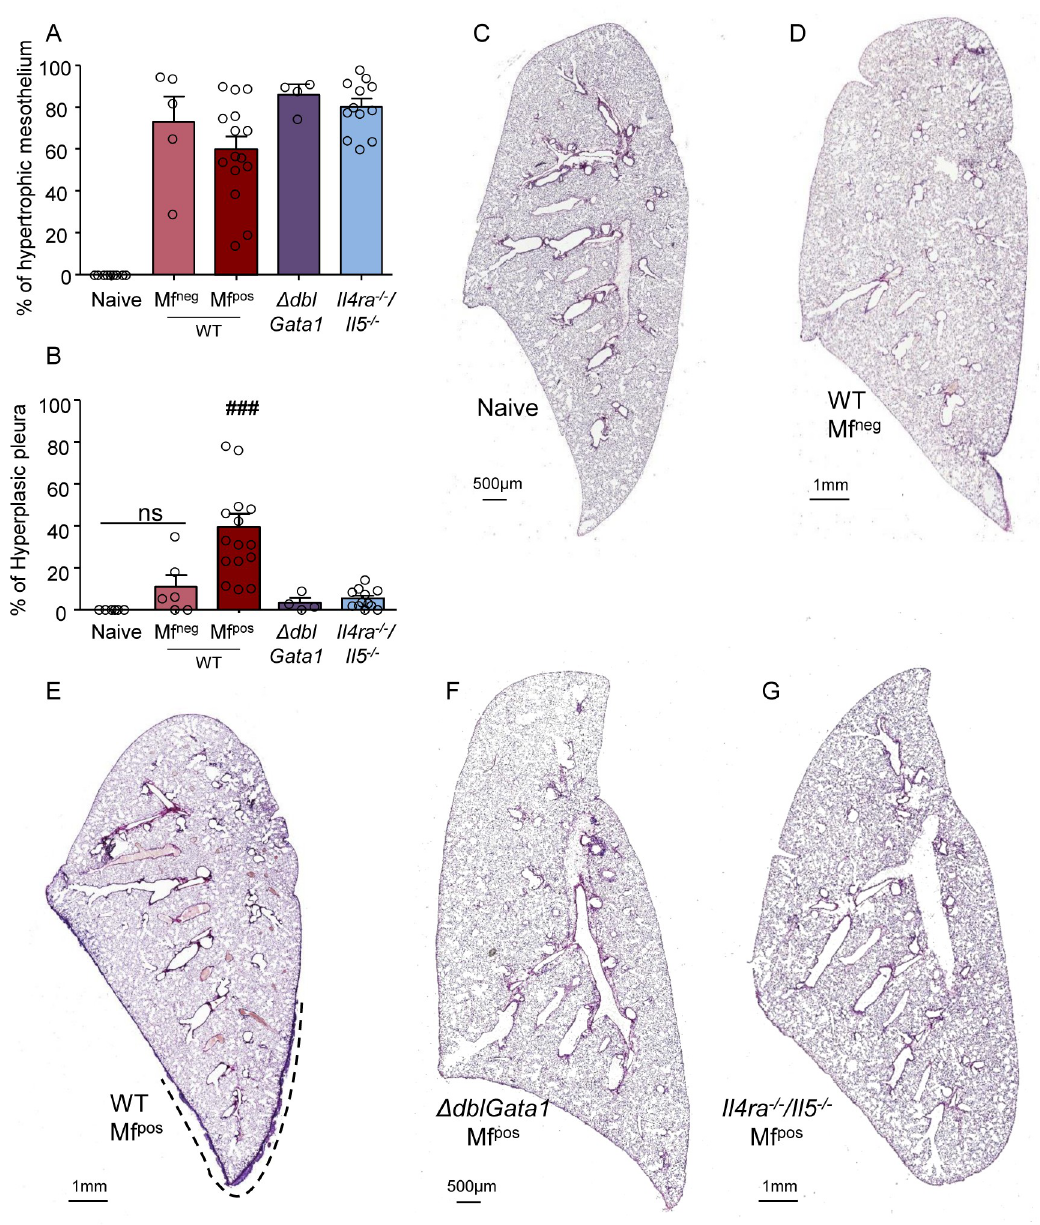
Fig 4. Absence of IL-4R and/or eosinophils protects from visceral pleura hyperplasia in microfilamic mice. L . sigmodontis infected wild type (WT), Δ dblGata1 and Il-4ra -/- /Il-5 -/- BALB/c mice were euthanized at 70 days p.i. Hematoxylin and Sirius red staining of left lung sections was performed to analyze the visceral pleura. ( A ) Proportion of visceral pleura with hypertrophic mesothelium. ( B ) Proportion of hyperplasic visceral pleura; results are expressed as mean ± SEM (pool of 2–3 experiments): n = 10 naive, n = 7 WT Mf neg , n = 15 WT Mf pos , n = 4 Δ dblGATA- Mf pos , n = 12 Il-4ra -/- /Il-5 -/- . Kruskal-Wallis followed by a Dunns multiple comparison test: ### p < 0.001 represent difference between naive and infested (C-G) Representative left lung whole section of ( C ) naive mice; ( D ) WT Mf neg mice; ( E ) WT Mf pos mice. The dashed line shows the hyperplasic area of the visceral pleura; ( F ) Δ dblGata1 Mf pos mice; ( G ) Il-4ra -/- /Il-5 -/- Mf pos mice.